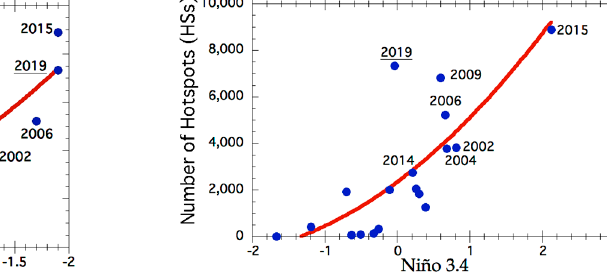
Figure 5. Averaged rainfall (TRMS) and OLR. 4.3.2. Rainfall during Dry Season